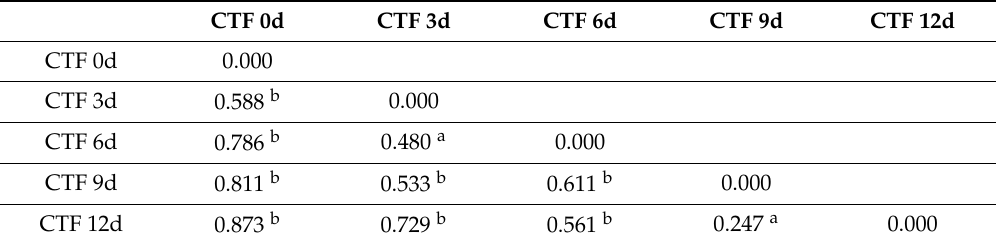
Table 4. Correlation matrix among the carrageenan coated trout fillets (CTF). The numbers indicate the discrimination indexes.